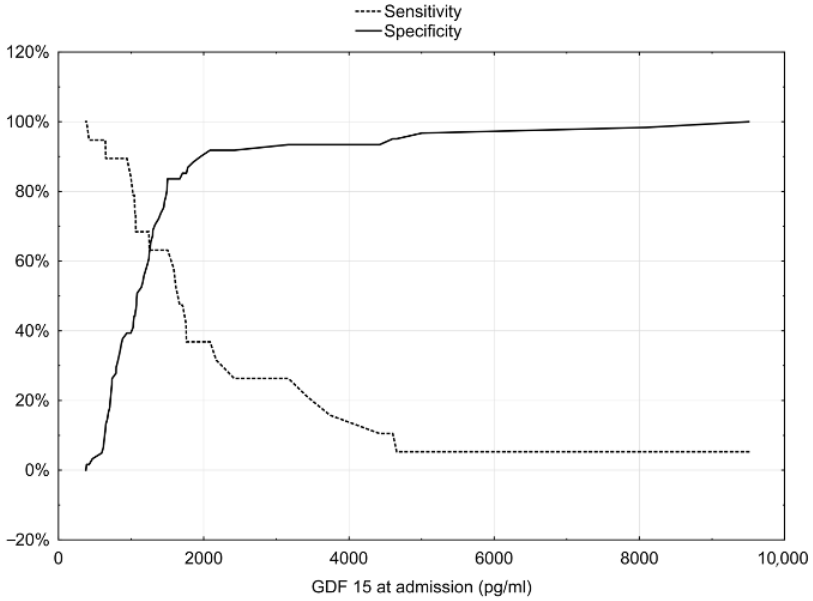
Figure 2. Sensitivity and specificity for GDF-15 concentration as a predictor of no-reflow. Table 4. Risk factors for no-reflow phenomenon in multivariate regression analysis.